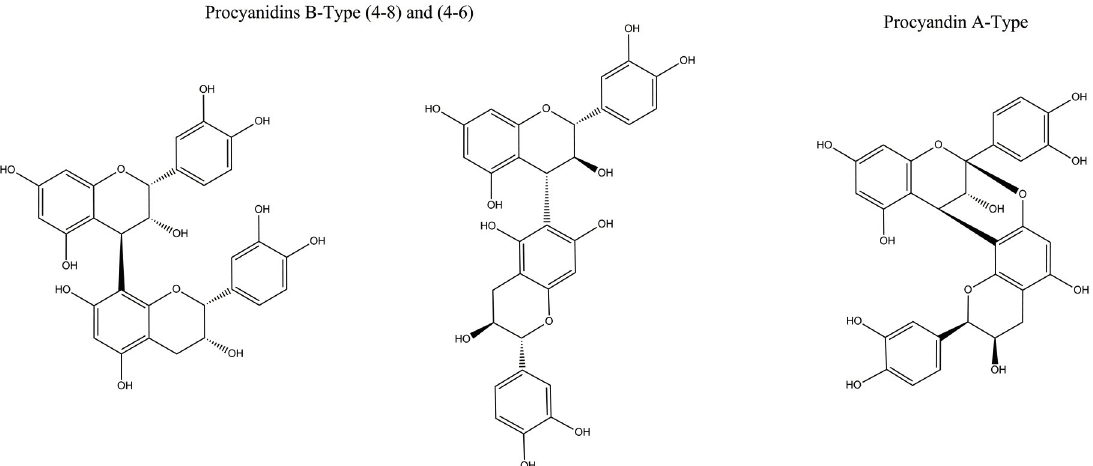
Figure 1. Structures of procyanidin (4 β→ 8) and (4 β→ 6)-dimers (B-type) and the (2 β→ 7, 4 β→ 8)-dimer